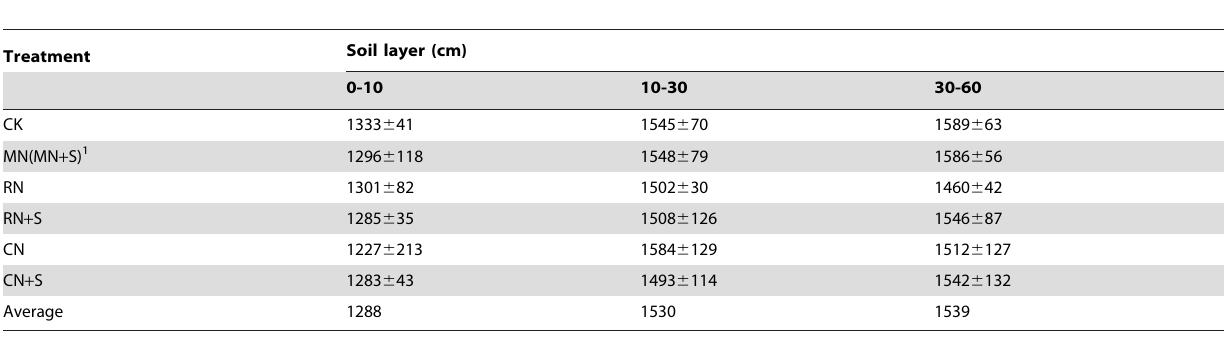
Table 2. Soil bulk density in the soil profile in Jan. 2010 in a year-round greenhouse tomato planting system in Shouguang, northern China (kg m -3